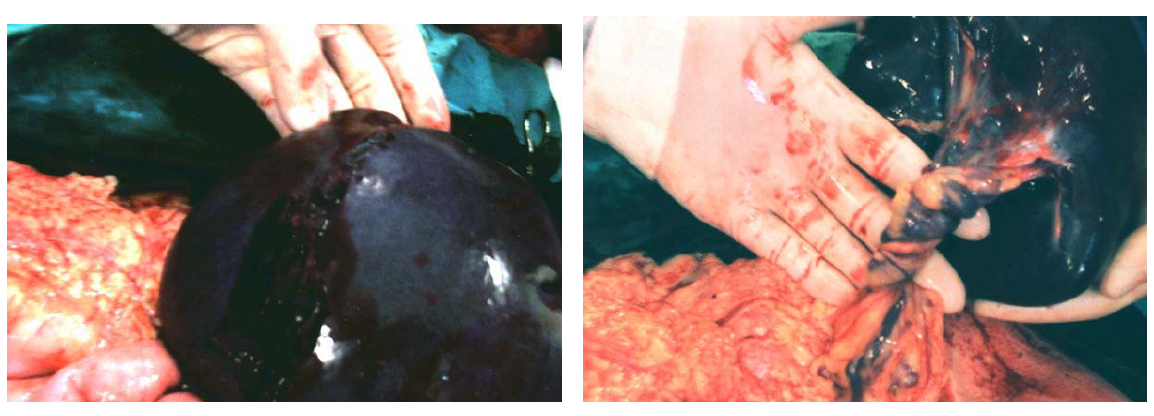
FIGURE 1 . Lacerated, infarcted, hypermobile spleen. FIGURE 2 . Torted vascular pedicle of wandering